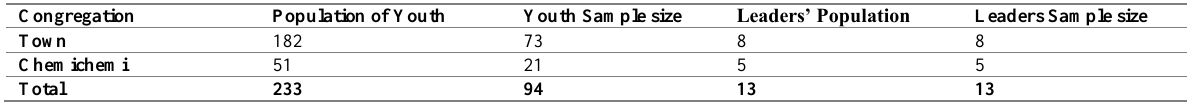
Table 1: Sampling Plan